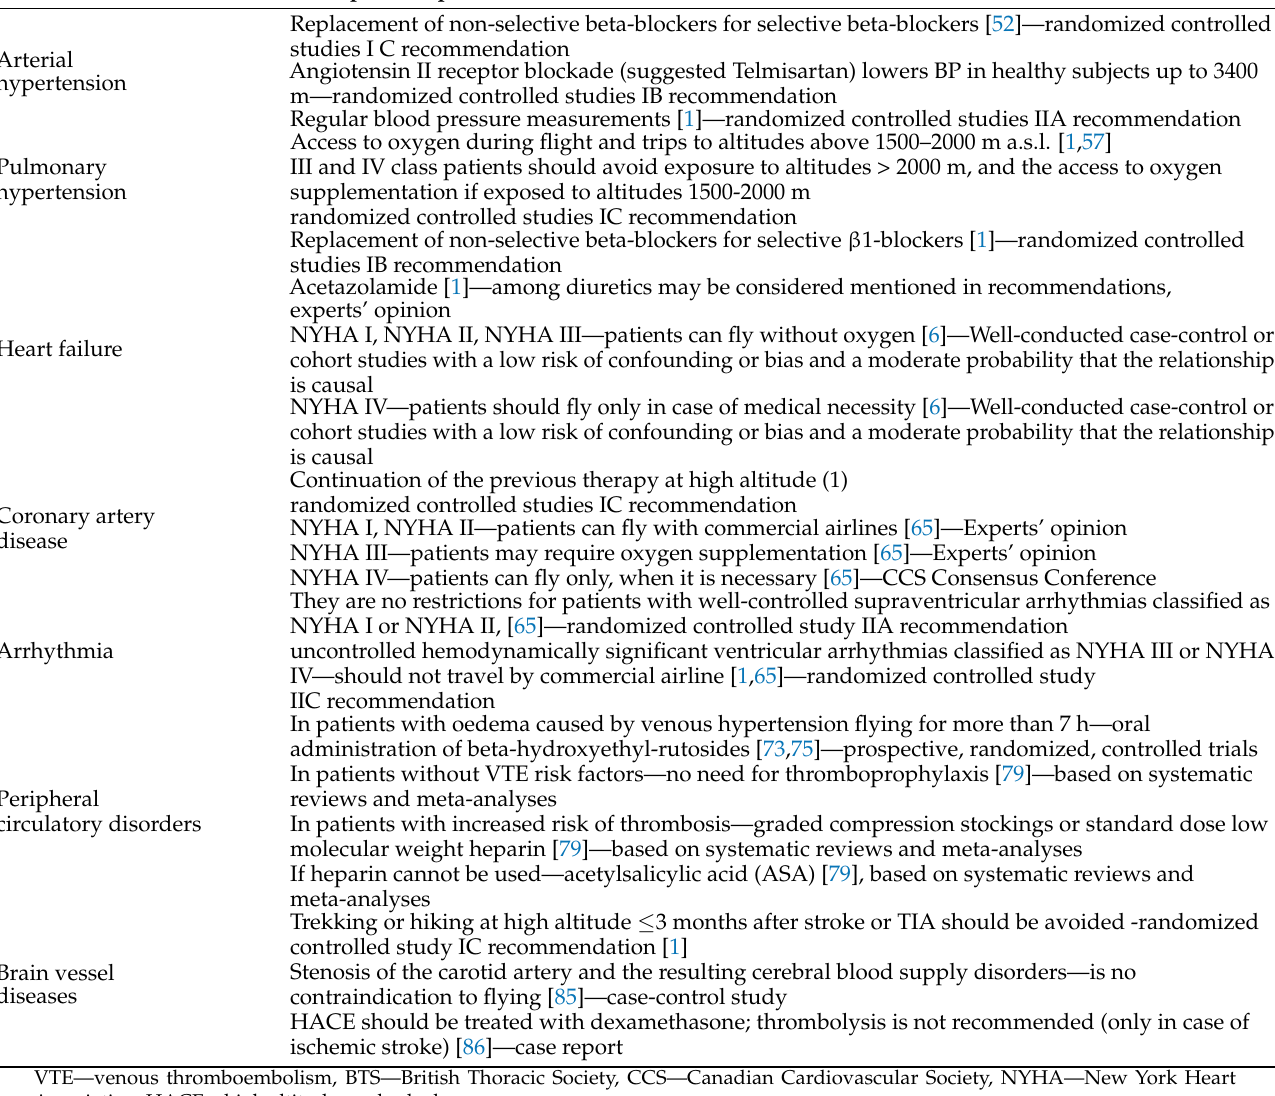
Table 2. Suggested therapeutic recommendations for patients with cardiovascular diseases at high altitudes. Disease Therapeutic